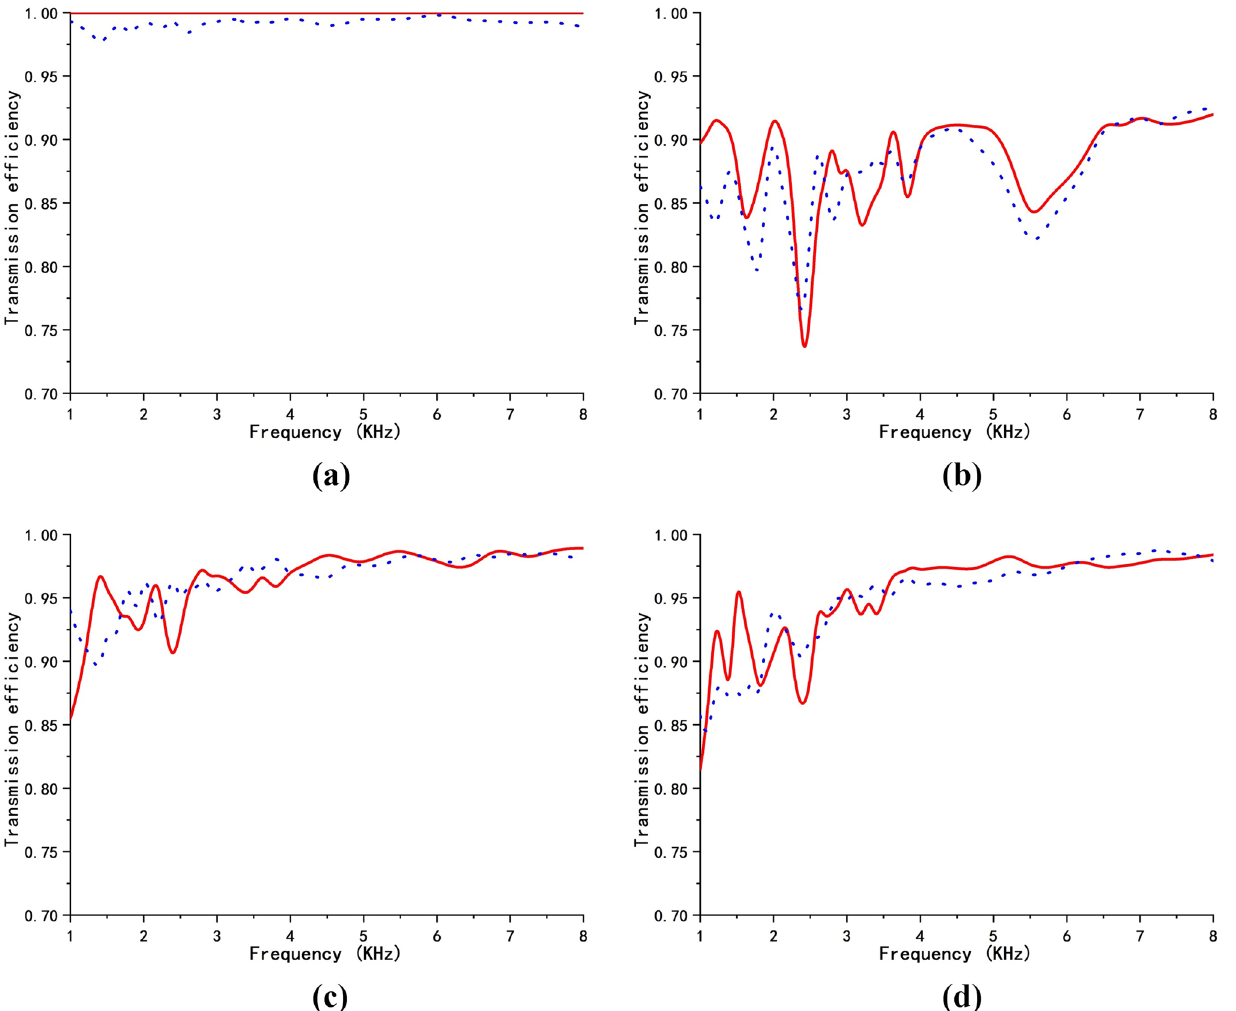
Figure 3. (color online) Transmission efficiency for the acoustic-wave cloak-design for the four cases. The solid red line and the dotted blue lines correspond to transmission efficiency in original space and physical space, respectively. ( a ) impedance function k k